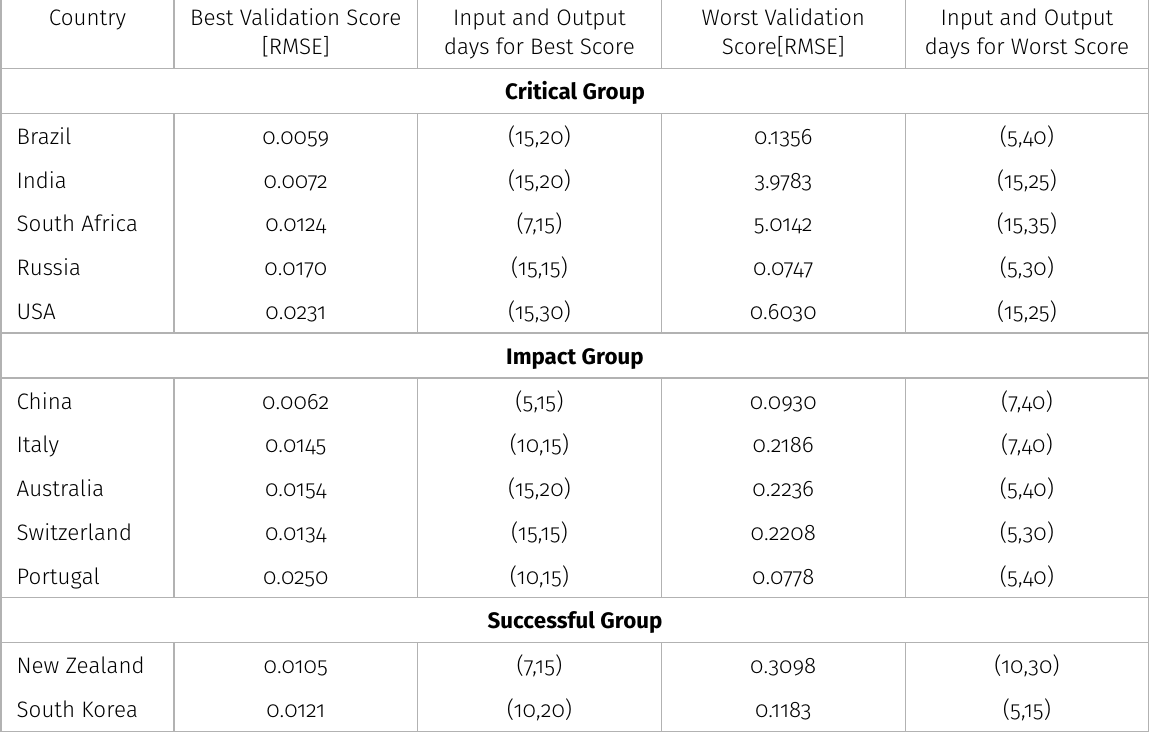
Table III. Best and worst validation results of LSTM models for daily COVID cases